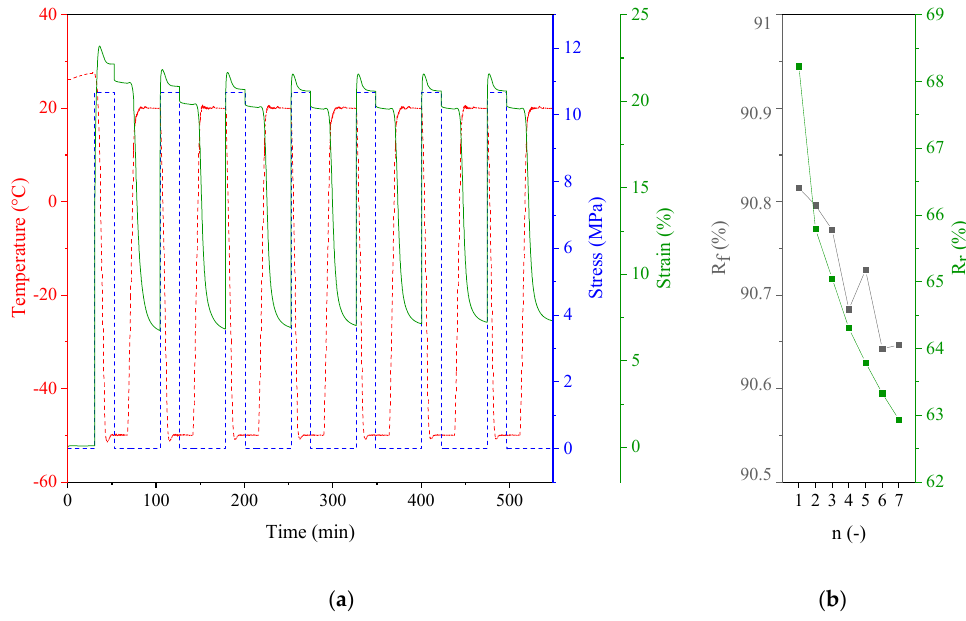
Figure 8. Shape memory properties of PHF- b -F-pTHF 25/75: ( a ) multiple thermomechanical cycles and ( b ) shape fixity (R f ) and shape recovery efficiency (R r ) vs. cycle number.